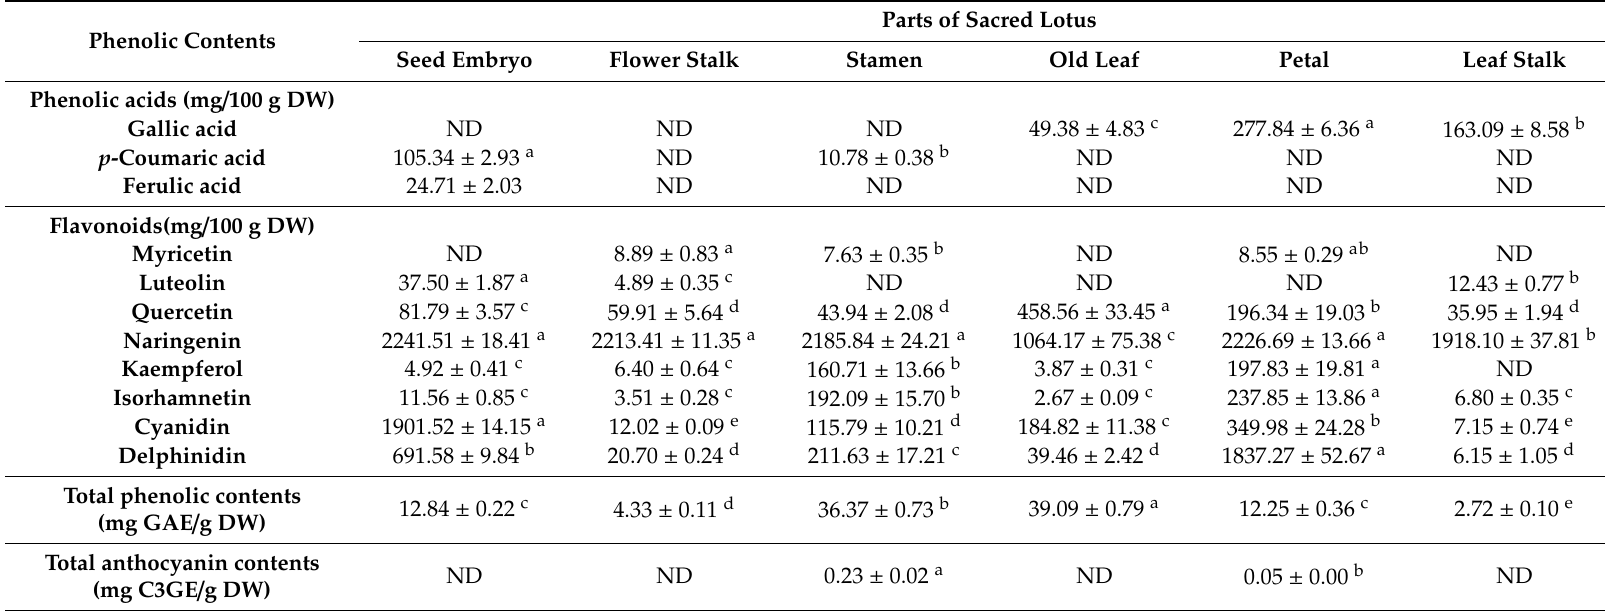
Table 4. Quantification of phenolics, total phenolic contents (TPCs), and total anthocyanin contents (TACs) in di ff erent parts of sacred lotus ( Nelumbo nucifera